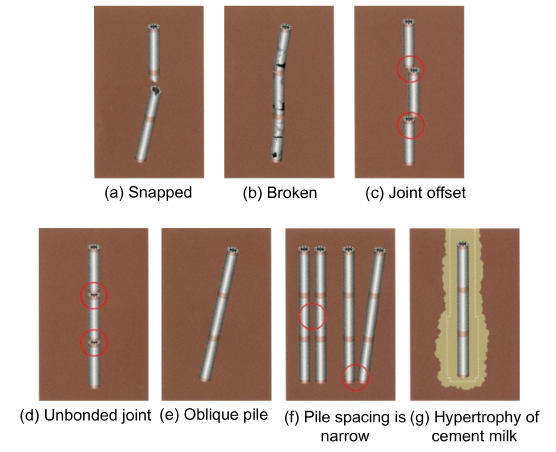
Figure 1. Examples of existing pile buried in an unhealthy